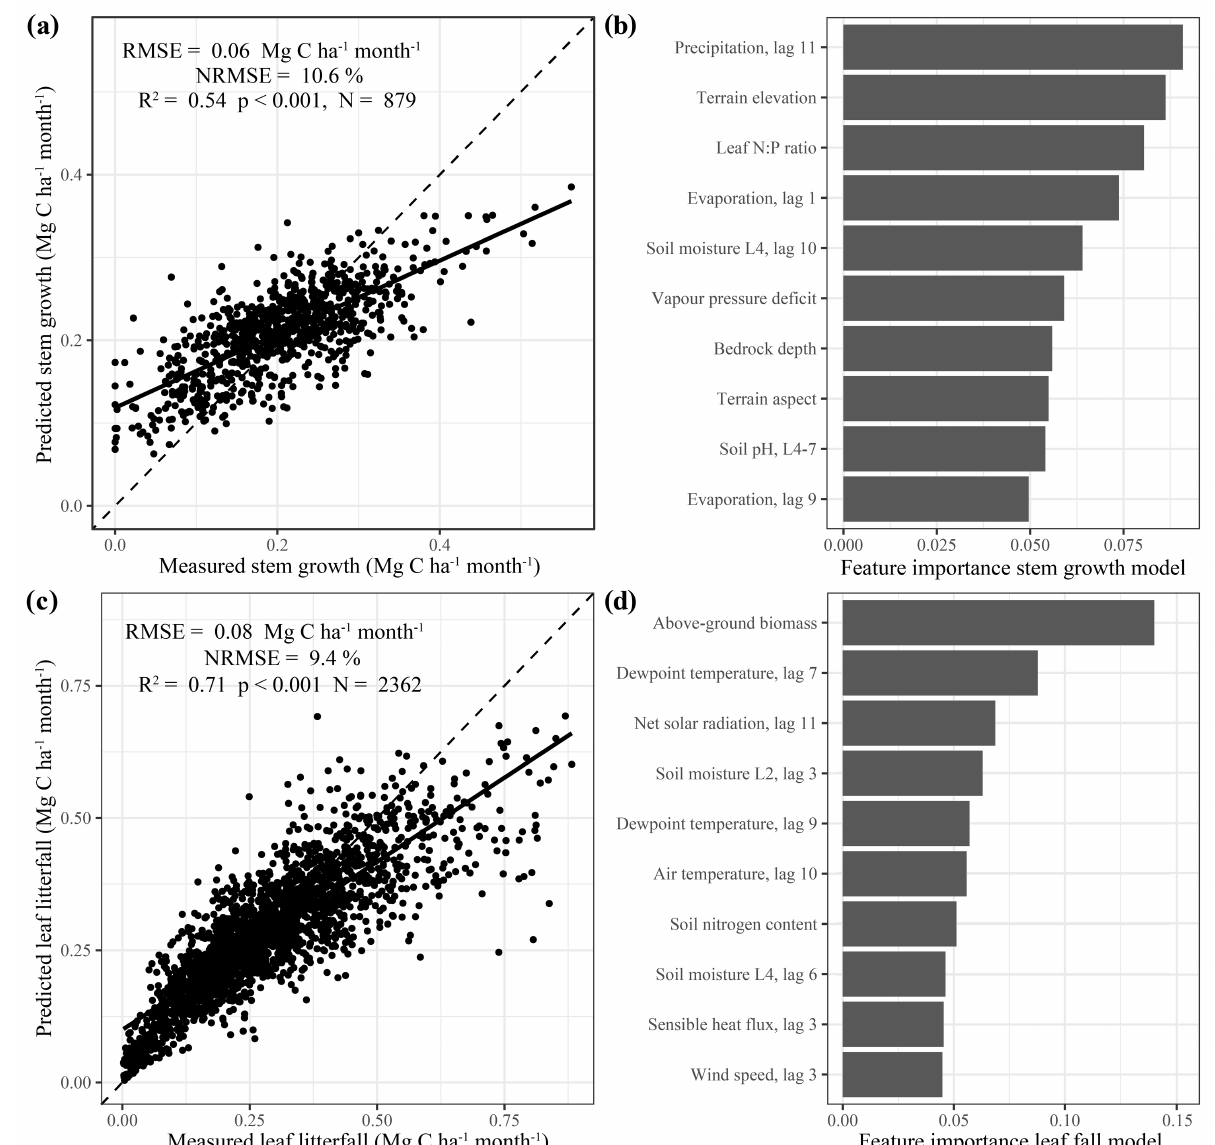
Figure 1. Model evaluation and feature importance. The scatterplots on the left side of panels (a) and (c) show the predicted biomass production versus the measured biomass production of the test data that were used to validate the stem growth (a) and leaf litterfall (b) models. The dashed black line is the 1 : 1 line, and the solid black line is the least-squares linear regression fit. The bar graphs on the right side of panels (b) and (d) show the feature importance (gain) of the top 10 features selected for the final models. Feature names are detailed in Table 1. Features with lags indicate the value of that climate variable a given number of months in the past (e.g. precipitation lag 11 is the monthly precipitation 11 months in the